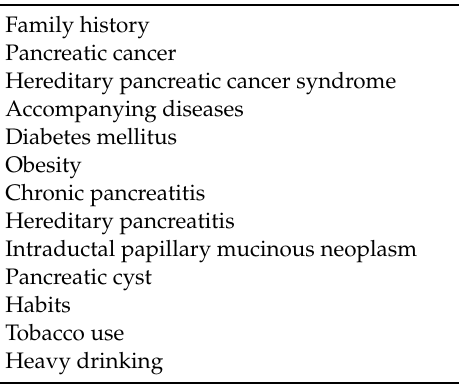
Table 1. Risk factors for pancreatic cancer.